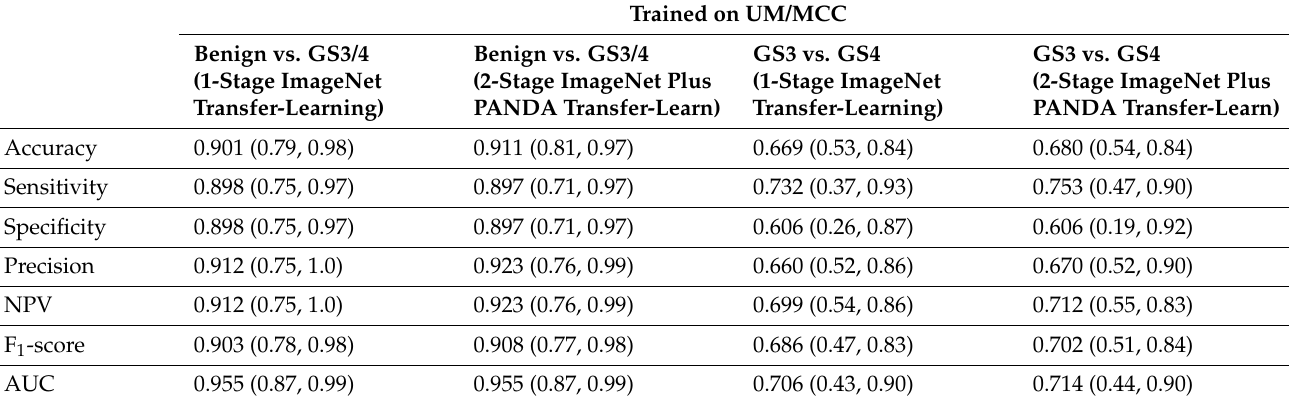
Table 4. UM/MCC performance 1-stage versus 2-stage (ImageNet + PANDA) training. Trained on